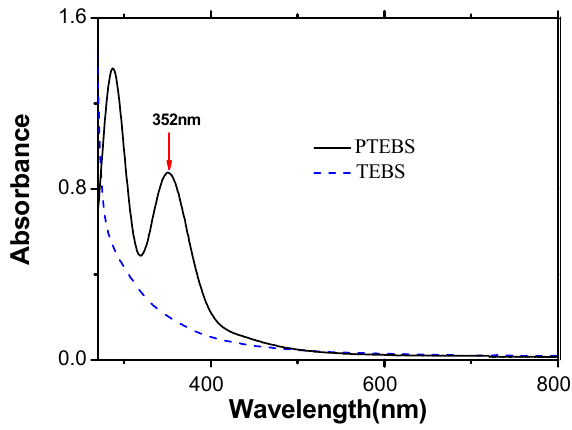
Figure 3. UV–Vis spectra of monomer TEBS and polymer PTEBS.